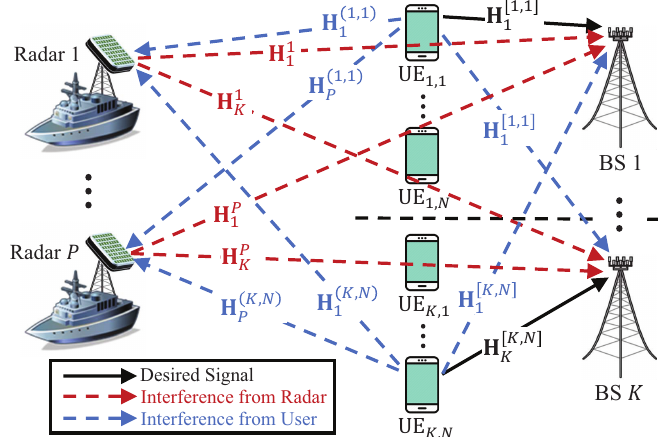
Figure 1. System model of spectrum-shared MIMO radar and MIMO communication